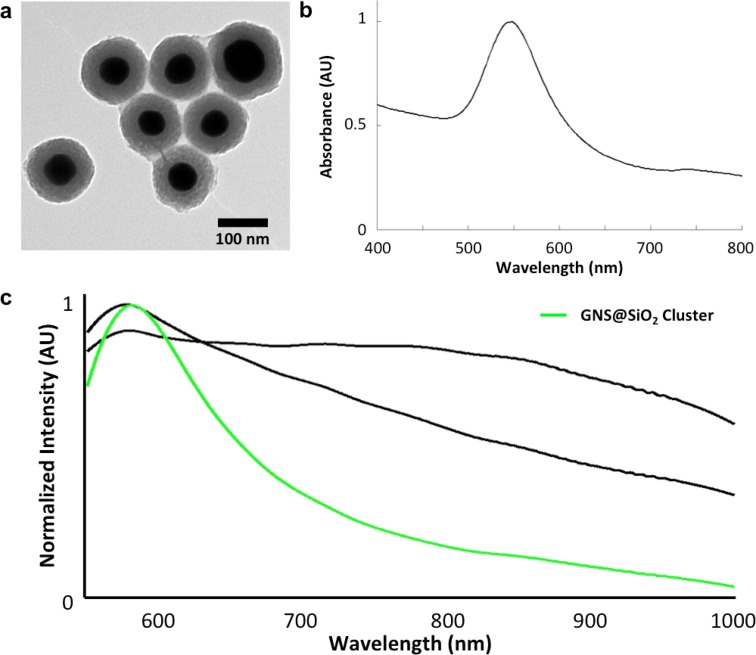
Structural and spectral characterization of GNS@SiO2.(a) TEM of GNS@SiO2. (b) Vis-NIR absorbance spectrum of GNS@SiO2 in water (SPR ~550 nm). (c) Spectral library clusters identified from training on images of unstained tissues (in CytoSeal) resected from mice injected with GNS@SiO2. The target number of clusters was set to three rather than five (used for LGNR detection) due to the absence of H&E staining. Cluster 2 (green) corresponds to the GNS@SiO2 and exhibits a red-shifted plasmonic peak relative to particles in water, as expected due to the difference in refractive environment.